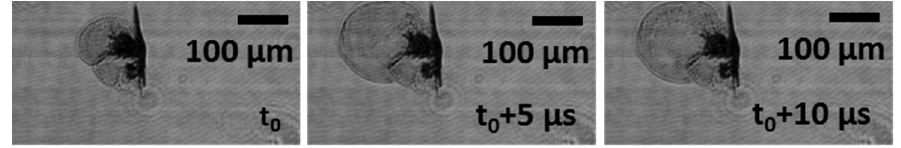
Figure 5. Sequential images of the PMMA ultrafast laser interaction process. The frame temporal separation is 5 µ s. Process parameters: 200 kHz pulse frequency, 25.4 W average power, V feed = 100 mm/s. Explosion-like expansion of the intra-material crack can be easily seen in the second frame, which is getting filled with the liquid and gaseous phases seen in the third image. See Video S2 .